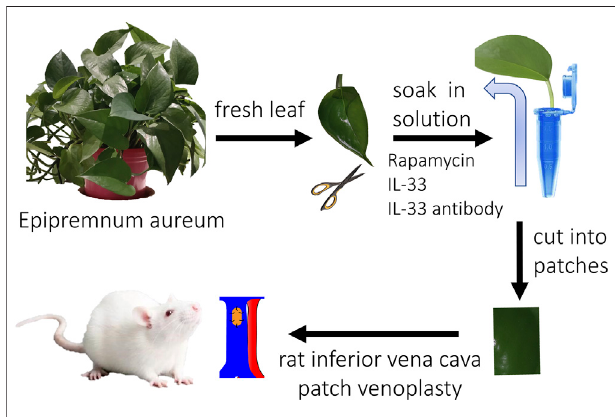
FIGURE 1 | Illustration photograph showing the study design (This illustration was created by